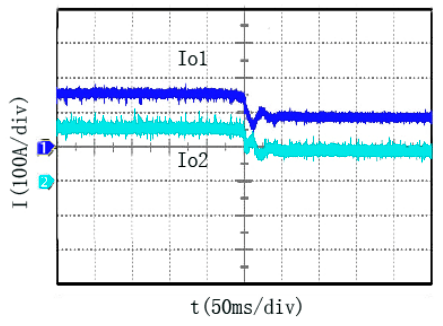
Figure 19. Switching the heavy load to the light load.